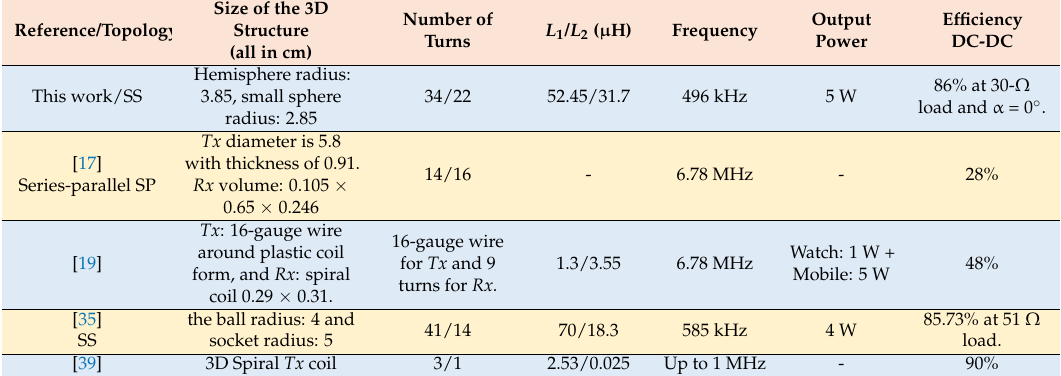
Table 6. Comparison of numerical results to other relevant